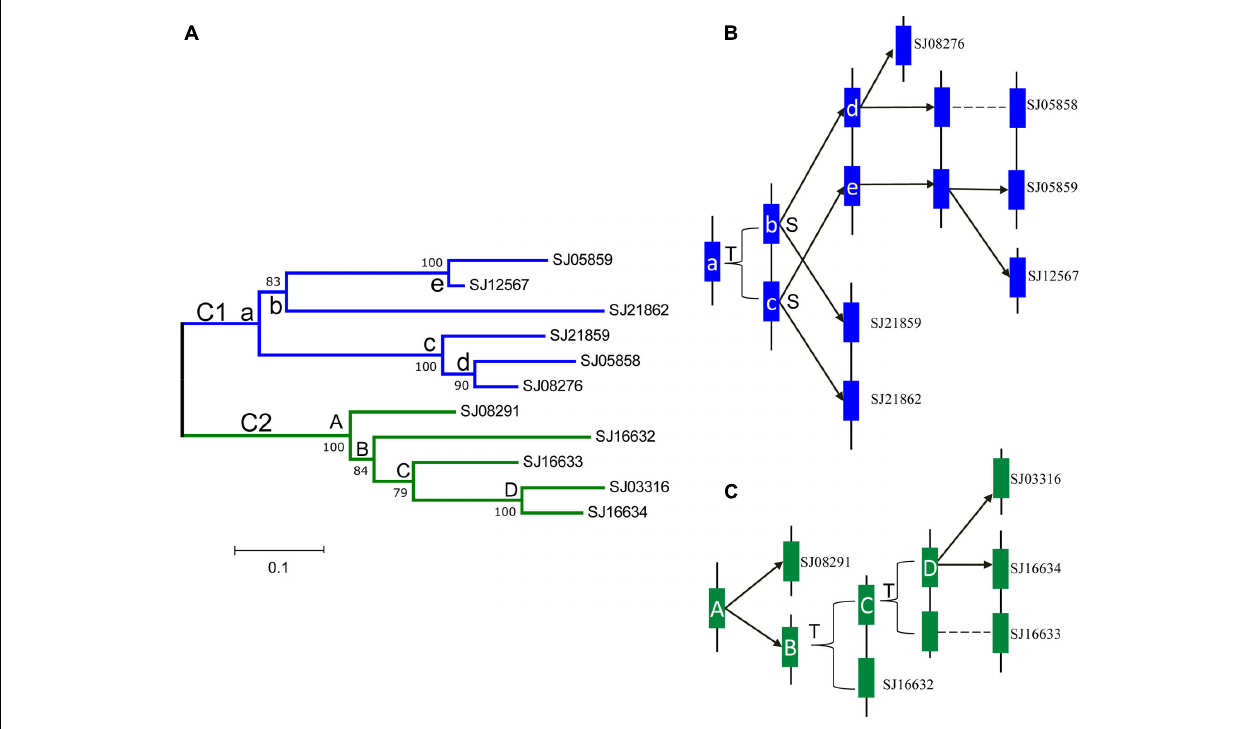
FIGURE 7 | Phylogenetic relationships and hypothetical evolutionary histories of the S. japonica LOX genes in Class 1 and 2. (A) Phylogenetic relationships were reconstructed using MEGA7.0. (B) The duplication histories of Class 1. (C) The duplication histories of Class 2. The letters T and S indicate putative tandem duplication and segmental duplication events, respectively. The letters in the tree and blue, green boxes represent ancestral LOX